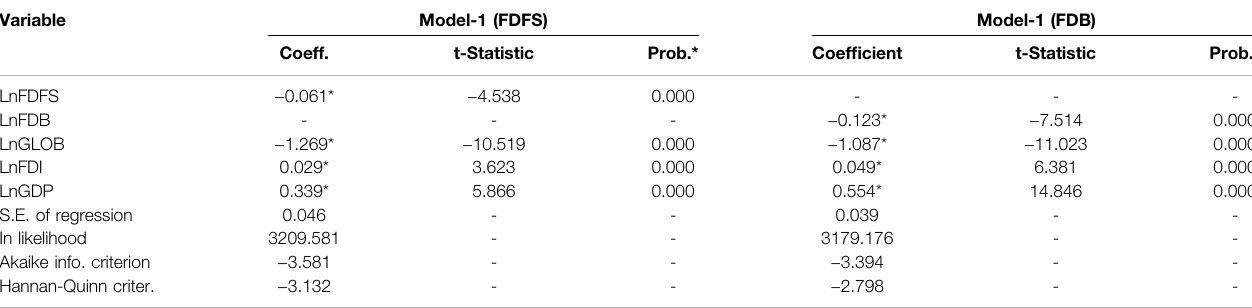
TABLE 6 | Results of PMG ARDL Panel estimation. Variable Model-1 (FDFS)